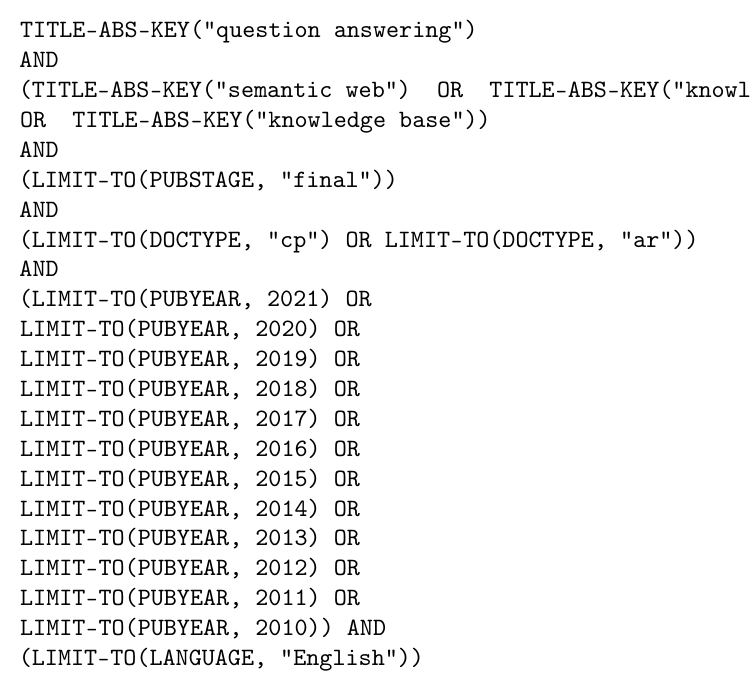
Figure A1. Query for collecting article from 2010 to